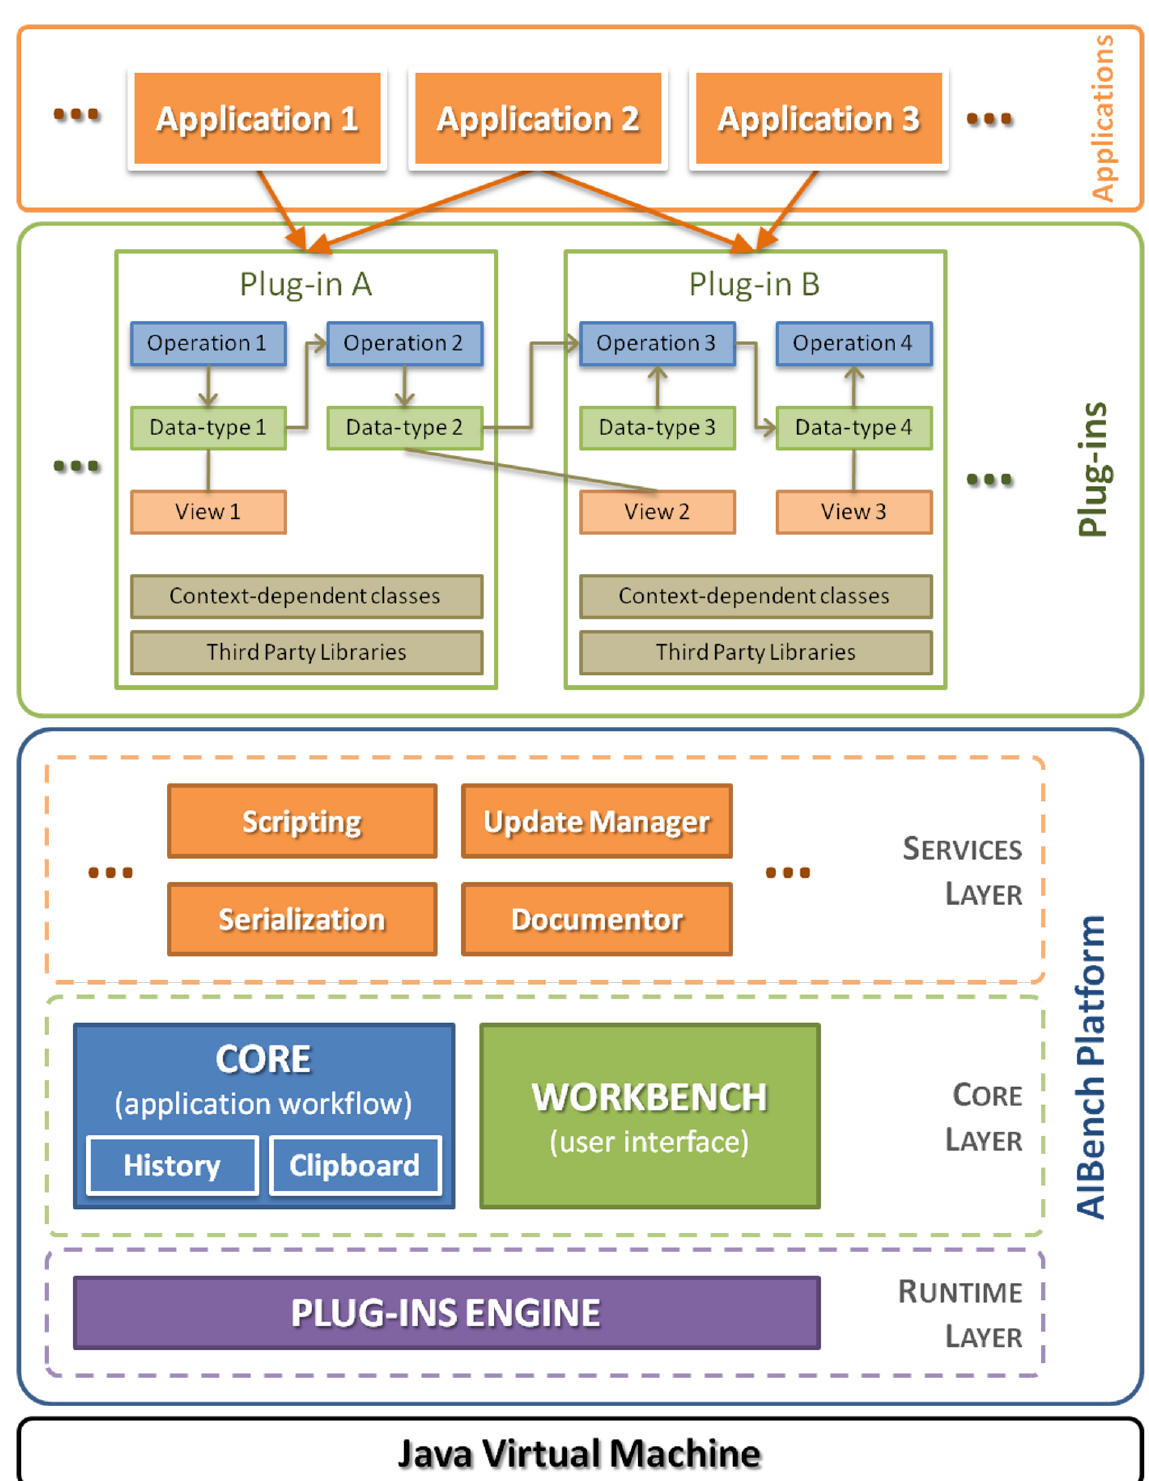
Figure 1: AIBench framework